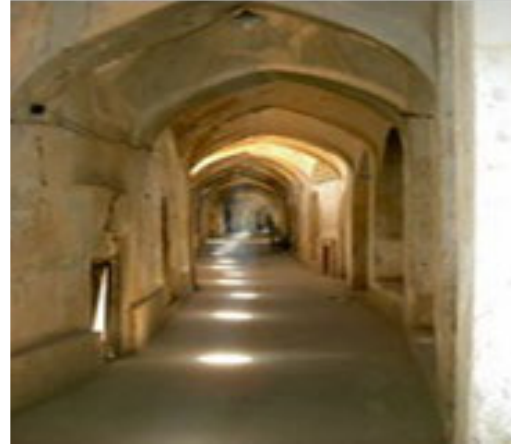
Fig. 7: Presence of people in squares and public Fig. 8: Naeen City market as the backbone of the Fig 7: Presence of people in squares and public Fig 8: Naeen City market as the backbone of the city